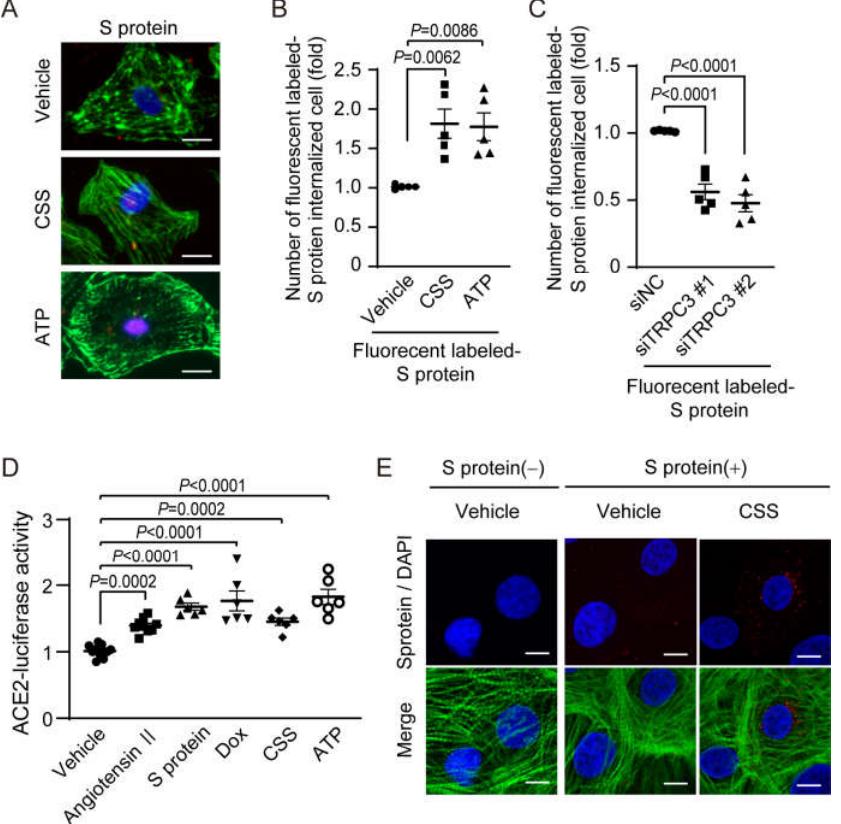
Figure 3. Enhanced S protein entry in NRCMs and hiPS-CMs by exposure to CSS and ATP. ( A ) Rep- resentative images of S protein incorporation in NRCMs by exposure to CSS (1%) and ATP (1 mM) for 24 h before stimulating by HiLyte Fluor 555-labeled S protein (50 nM) for 3 h (red). The S protein-exposed NRCMs were fixed and co-stained with phalloidin (green) and DAPI (blue). Scale bars = 10 µ m. ( B ) Number of HiLyte FluorTM 555 -labeled-S protein-incorporated NRCMs in ( A ). ( C ) Number of S protein-incorporated NRCMs with or without silencing TRPC3. ( D ) ACE2 transcriptional activities in hiPS-CMs. hiPS-CMs were treated with Ang II (1 µ M), ATP (1 µ M), Dox (1 µ M), and CSS (1%) for 24 h. ( E ) Representative images of S protein incorporation in hiPS-CMs exposed to CSS (1%) for 24 h before stimulating with HiLyte Fluor 555-labeled S protein (50 nM) for 3 h (red). The hiPS-CMs were co-stained with phalloidin (green) and DAPI (blue). Scale bars = 10 µ m. All data are shown as mean ± SEM; n = 5–8. Significance was imparted using one-way ANOVA followed Tukey’s comparison